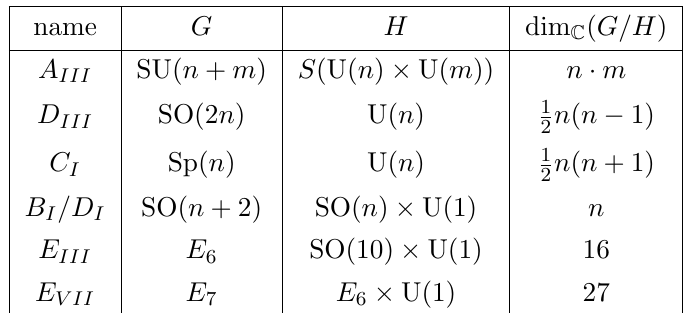
Table 2 . The four in(cid:12)nite series and the two exceptional cases of the Hermitian symmetric spaces. the Hermitian symmetric spaces are the four in(cid:12)nite series A two exceptional spaces E